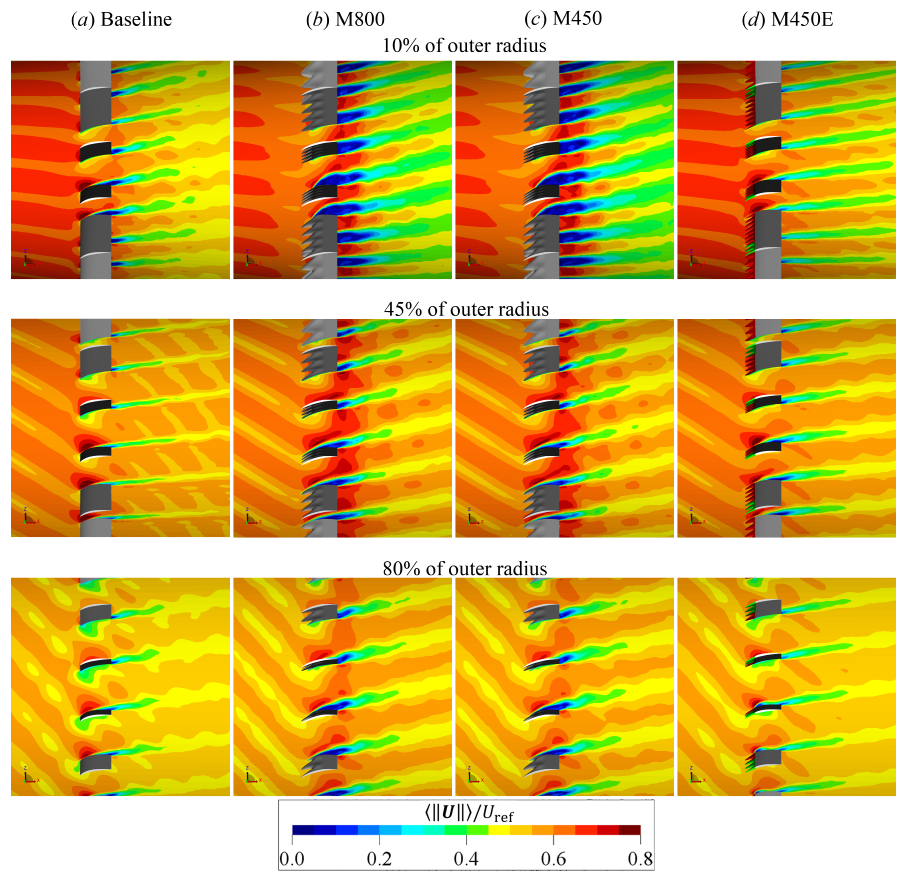
Figure 10. (Side view) Contours of phase-locked average of velocity magnitude || U || at the different radial sections ( top —10%, middle —45%, and bottom —80% of the outer radius) in the fan